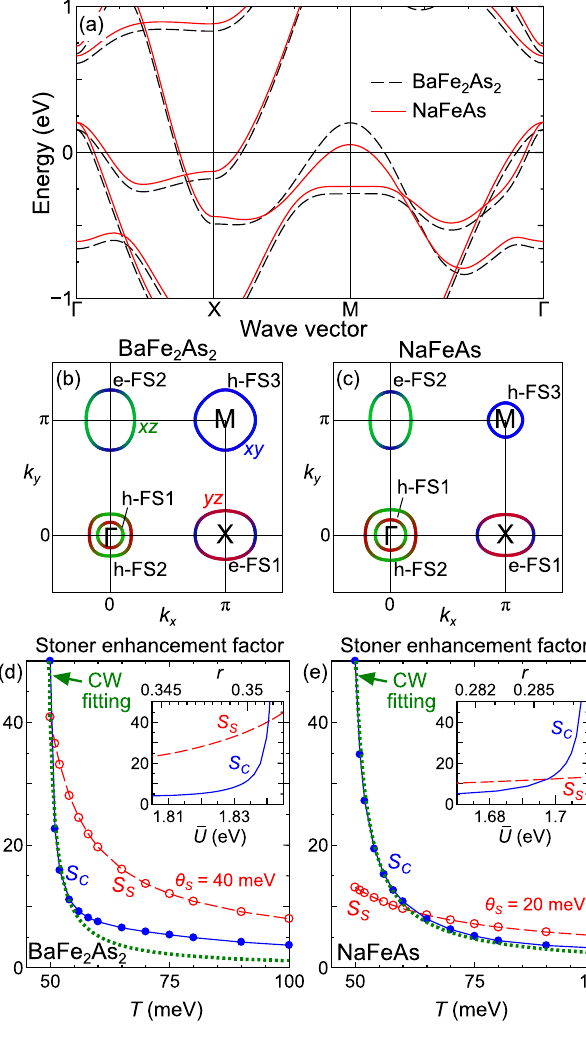
FIG. 8. (a) Band structures of H 0 H 0 and (c) FSs of H 0 BaFe 2 As 2 (charge) Stoner enhancement factors S ¯ U (Inset) dependence of the Stoner enhancement factors. (e) Spin and charge Stoner enhancement factors in H